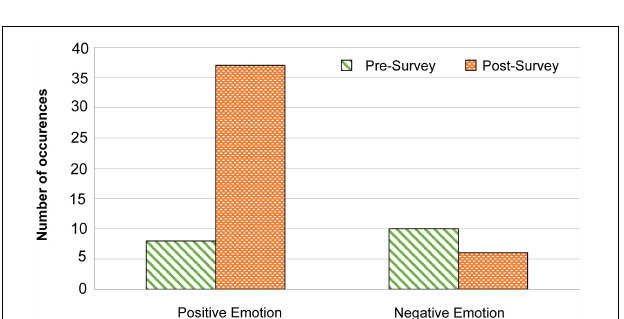
FIGURE 2 | Frequency of knowledge sub-categories. Results depicting the frequency of science subjects mentioned in the concept map question both pre and post survey. These subjects were coded through thematic analysis of question 1, which asked students to “write and/or draw what you think of when you hear the word science.”